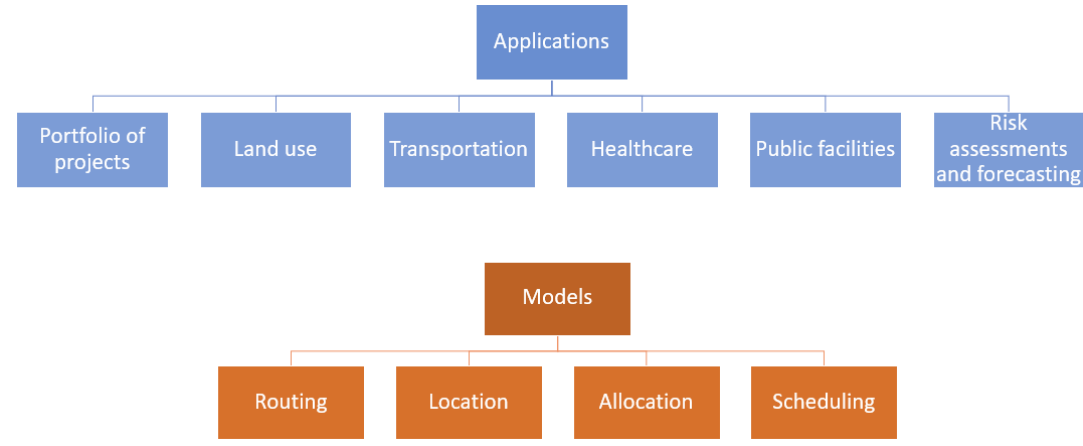
Figure 4. Applications and models of works on government decisions using